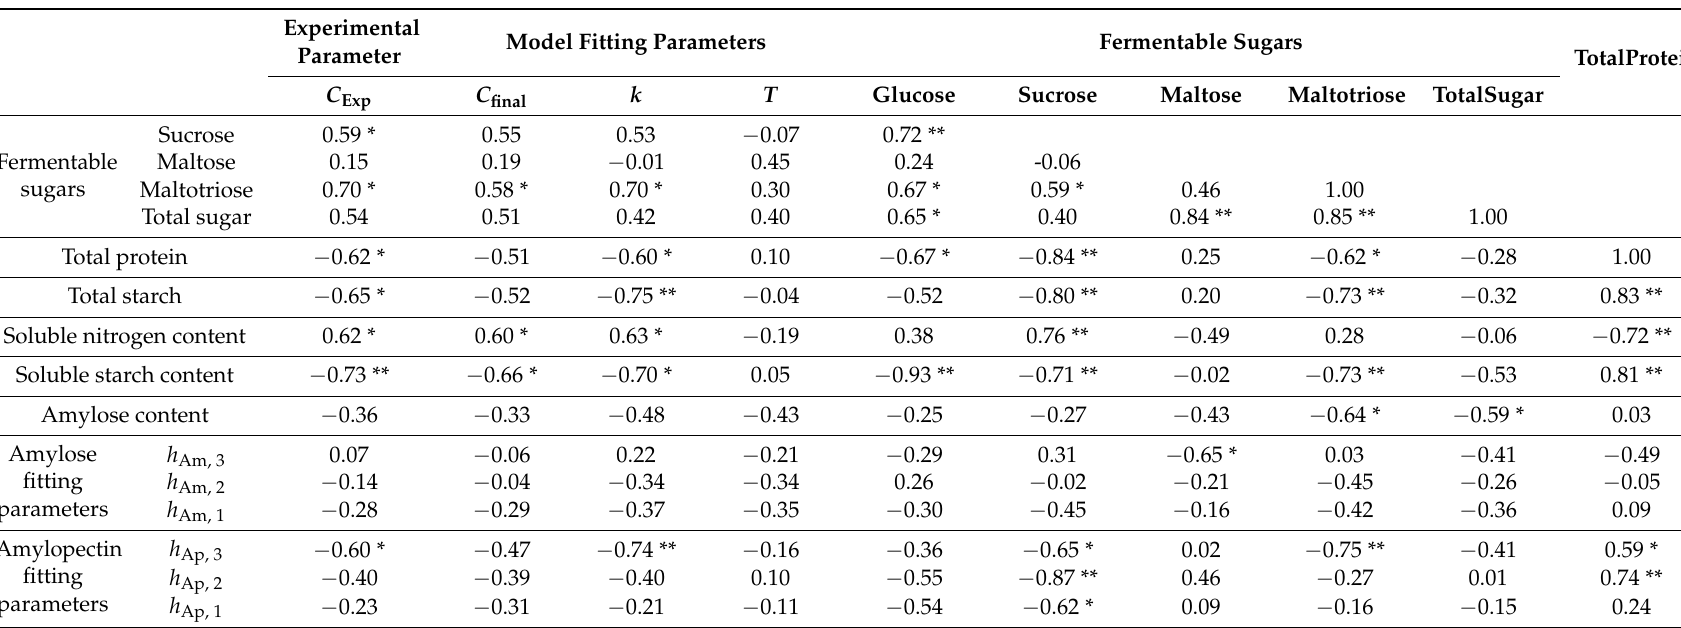
Table 5. Pearson correlations among fermentable sugars, fermentation parameters and chemical compositions of the malt and rice samples ( n = 12). Experimental